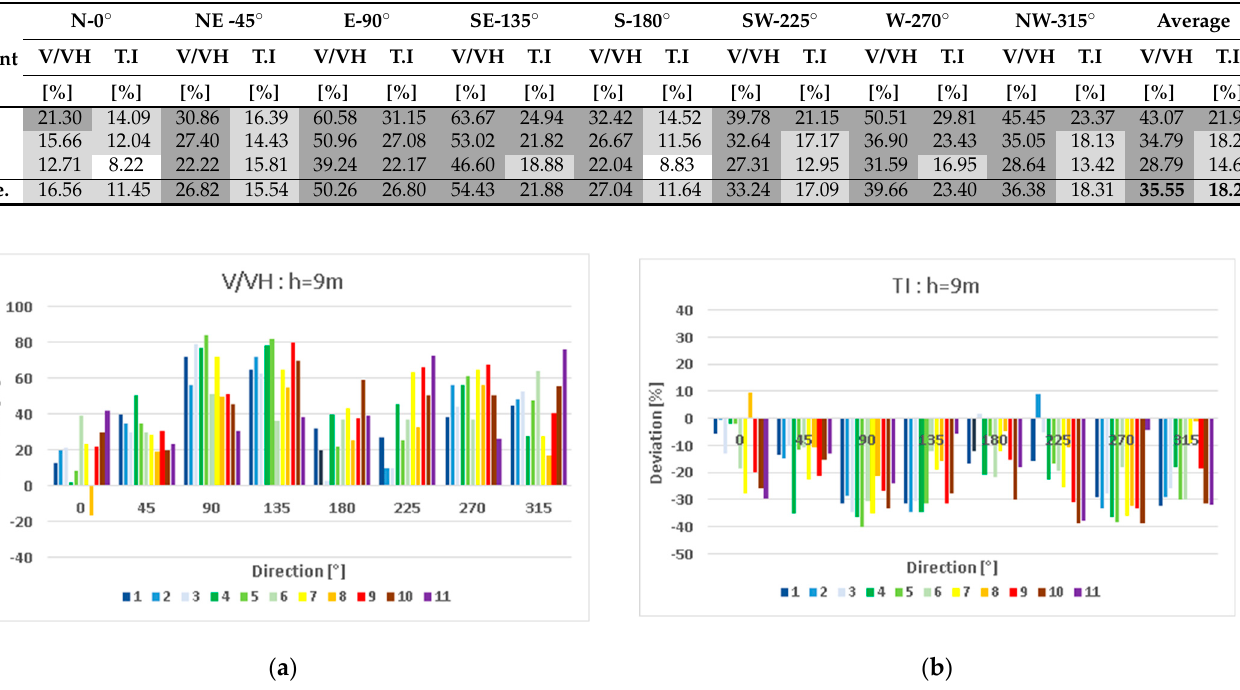
Figure 17. Mean absolute deviations of the wind ( a ) and turbulence intensity ( b ) per direction for the 11 probe validation points at height h = 9 m with WAsP Engineering.